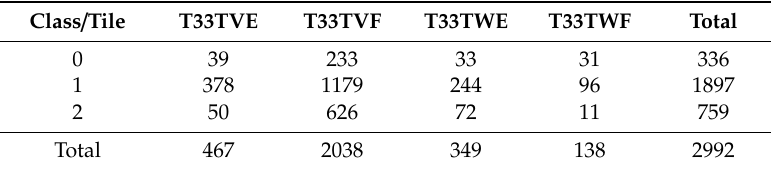
Figure 6. NDVI time series and accumulated rainfall data at pixel scale. Example of (a) class 0 (rainfed and bare soil) in phase and (b) class 1 (herbaceous) not in phase. Table 4. Number of reference data acquired per tile and per